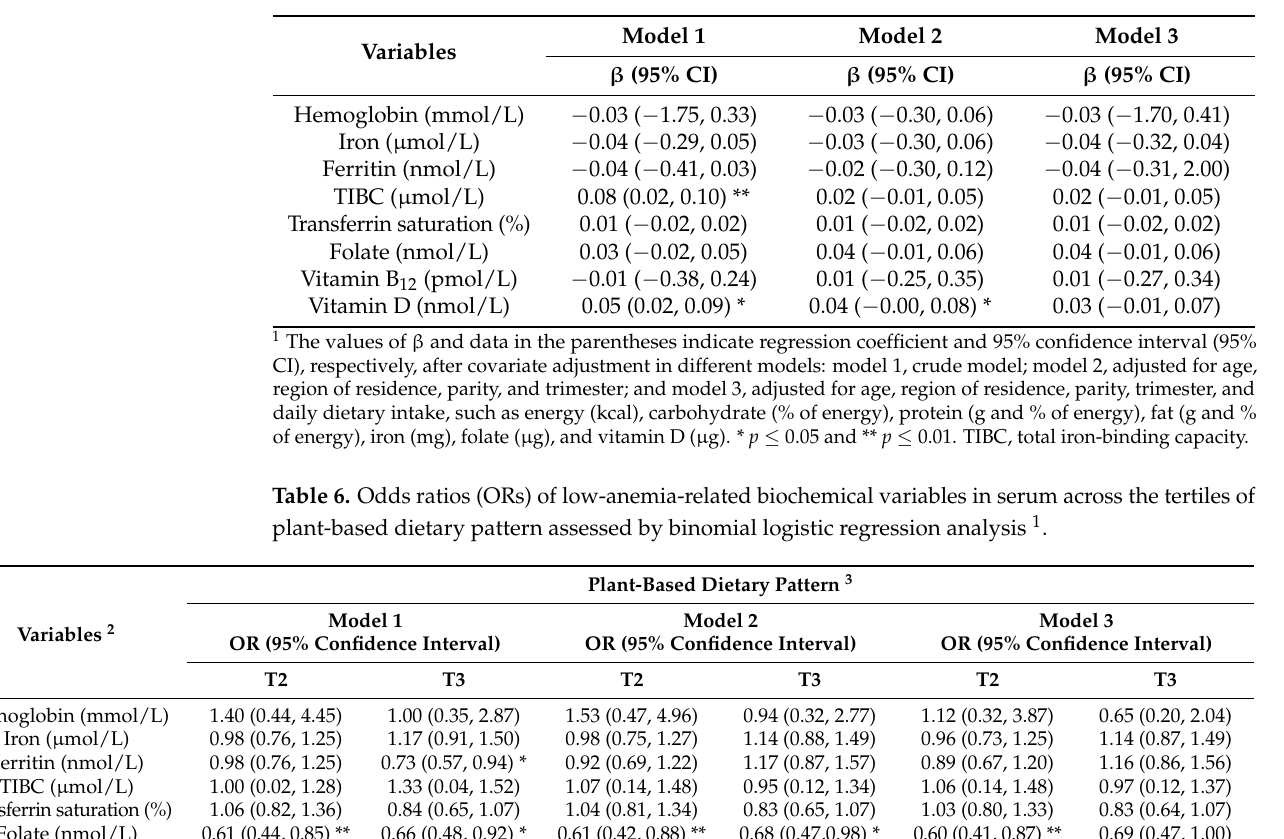
1 Three different models were performed in binomial logistic regression analysis: model 1, crude model; model 2, adjusted for age, region of residence, parity, and trimester; and model 3, adjusted for age, region of residence, parity, trimester, and daily dietary intake, such as energy (kcal), carbohydrate (% of energy), protein (g and % of energy), fat (g and % of energy), iron (mg), folate ( µ g), and vitamin D ( µ g). 2 Variables were divided into two levels on the basis of cutoff values in serum: hemoglobin, 6.52 mmol/L (10.5 g/dL); iron, 10.7 µ mol/L (60 µ g/dL); ferritin, 0.034 nmol/L (15 ng/mL); TIBC, 42.96 µ mol/L (240 µ g/dL); transferrin saturation, 16%;